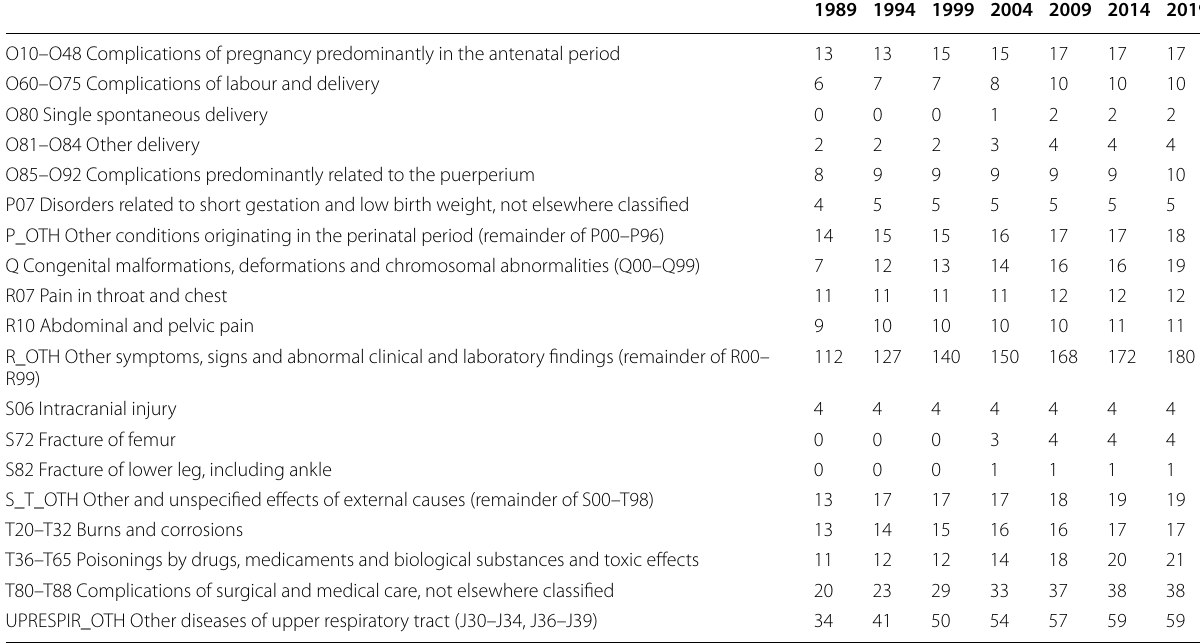
Table 8 Estimates of models that include multiple lag lengths (CUM_DRUG